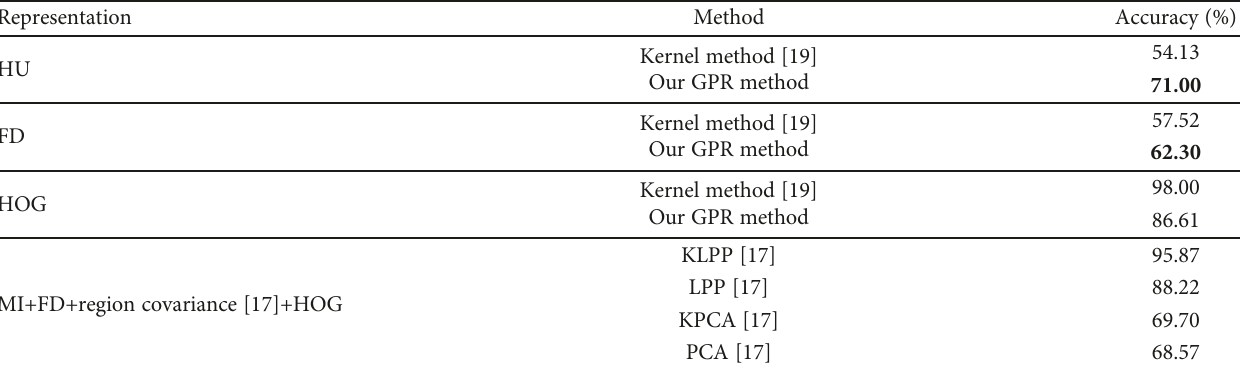
Table 1: Satellite recognition results on BUAA-SID 1.0 and comparison with [17, 19]. Results are in bold if the proposed method performs the best.